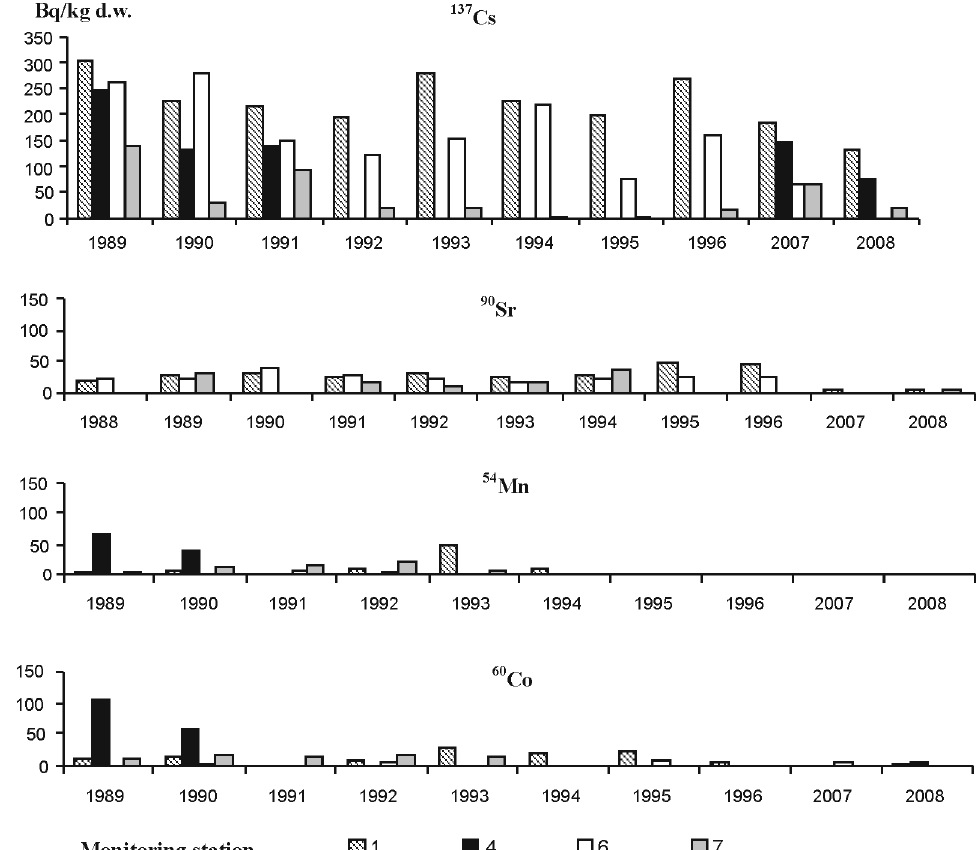
Fig. 2. Activity concentration of radionuclides in bottom sediment of Drūkšiai